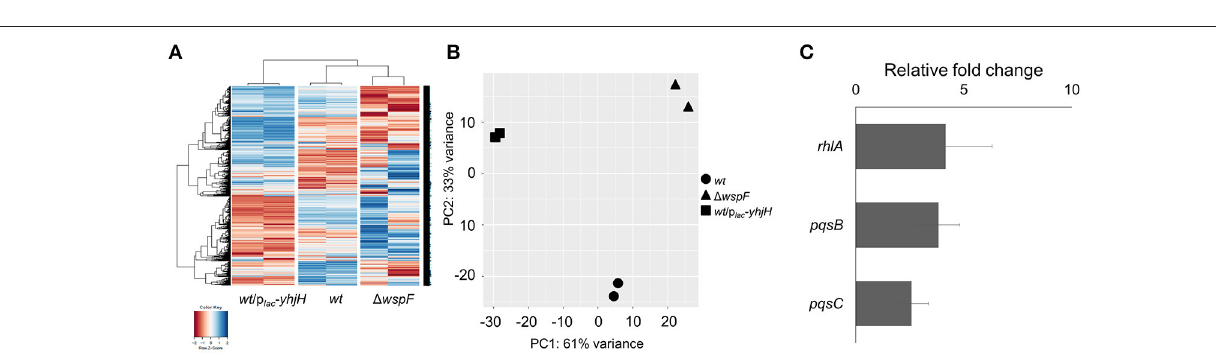
FIGURE 2 | Comparison of gene expression by the P. aeruginosa wild-type, high intracellular c-di-GMP containing 1 wspF mutant and low intracellular c-di-GMP containing P. aeruginosa /p lac -yhjH mutant. (A) Heat map and (B) PCA plot comparison of wild-type, 1 wspF and P. aeruginosa /p lac -yhjH . (C) qRT-PCR analysis of rhlA , pqsB and pqsC expression in P. aeruginosa /p lac -yhjH culture relative to 1 wspF strain. Means and s.d. from triplicate experiments are